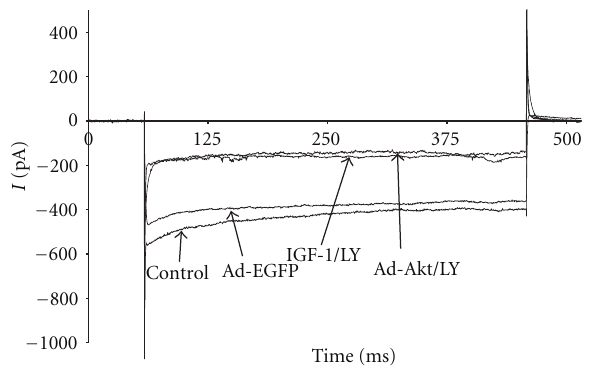
Figure 8: Recording representative of the time courses for the e ff ects of IGF-1 and Ad.Akt in combination with LY294002 treatments on I K1 of normal neonatal rat cardiomyocytes at the clamp voltage of − 120 mV. Current expressed as